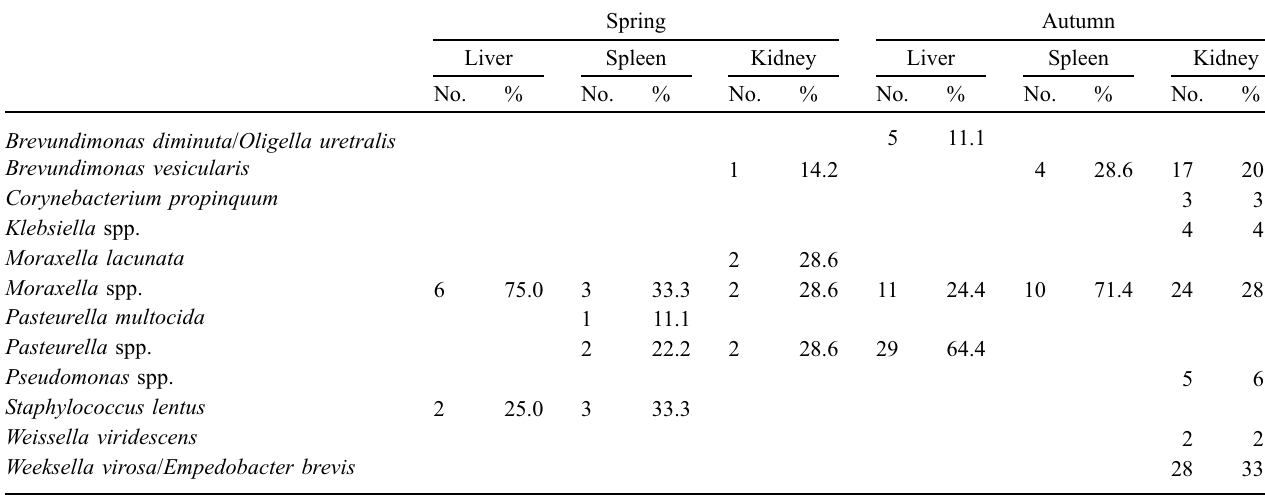
Spring Autumn Liver Spleen Kidney Liver